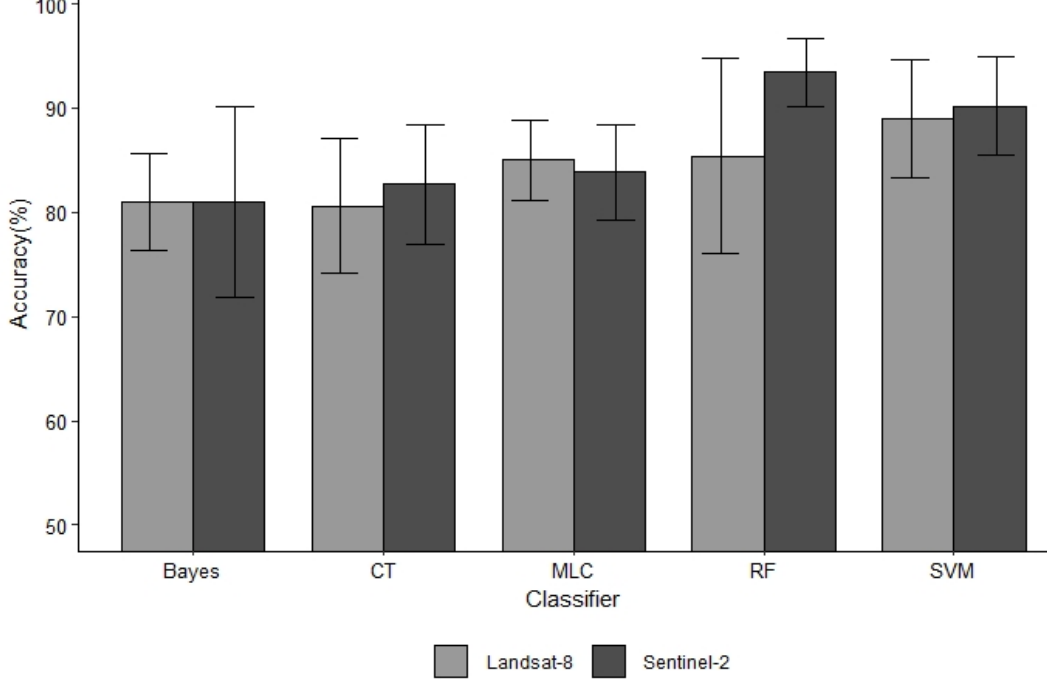
Figure 6. Accuracy of Sentinel-2 land cover / use mapping based on di ff erent classifiers from the reviewed studies based on 50 case studies (25 for Sentinel-2, and 25 for Landsat-8). Five studies were considered for each classifier. Note that RF refers to random forest, MLC is maximum likelihood classifier, SVM is support vector machine, CT is classification tree and k-NN is k nearest neighbour.